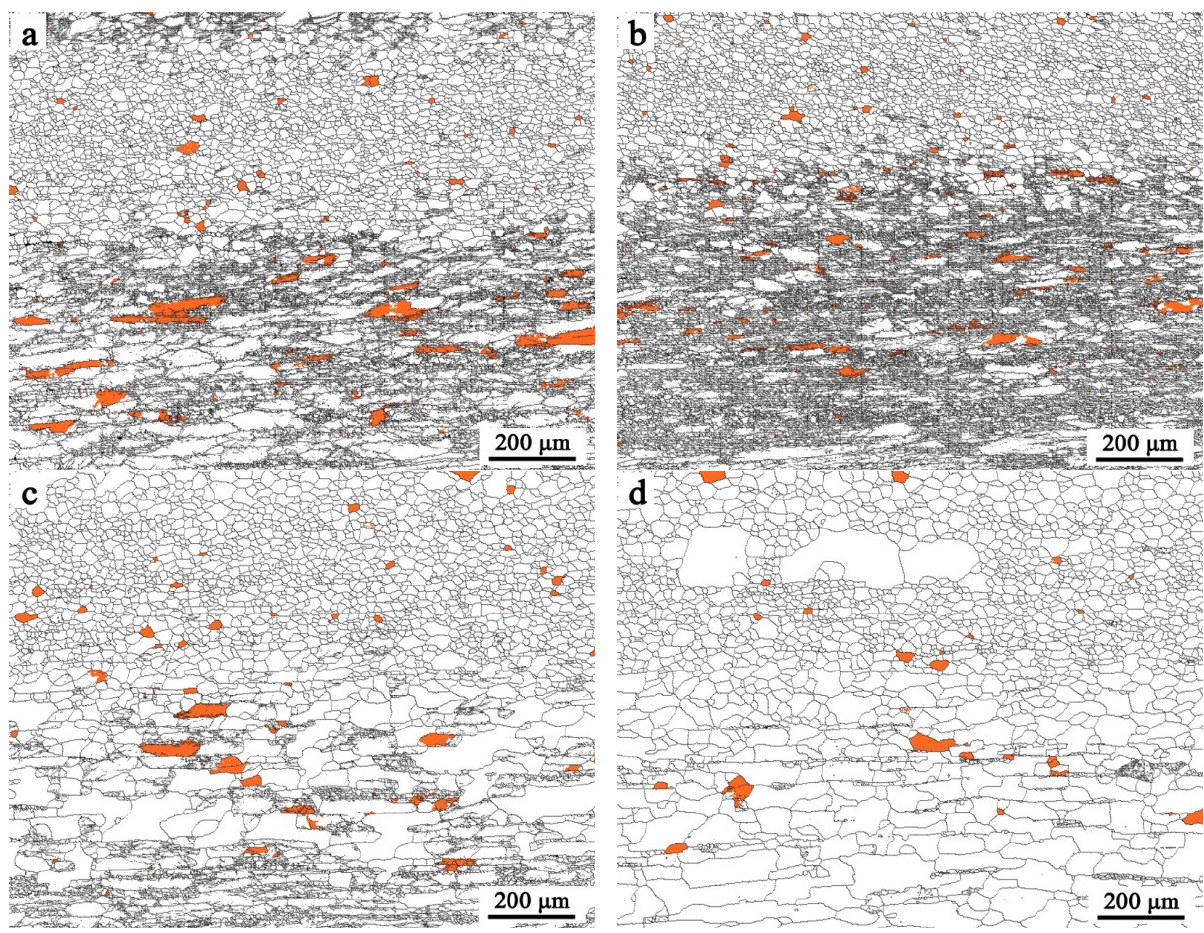
Figure 5: Goss texture of (a) S1-hot rolled, (b) S2-hot rolled, (c) S1-normalized, and (d) S2-normalized (Orange zone is Goss texture within 10 ∘ of exact Goss